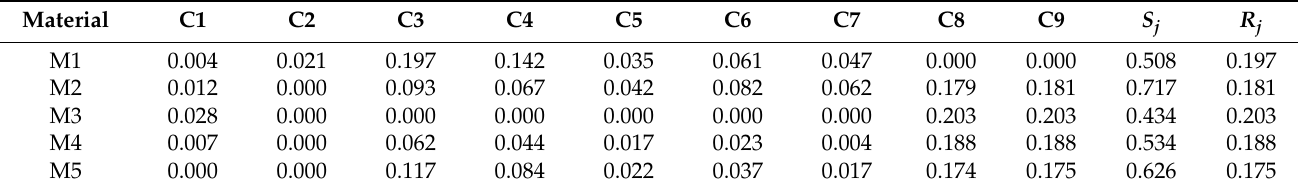
Table A4. VIKOR calculations (AHP).